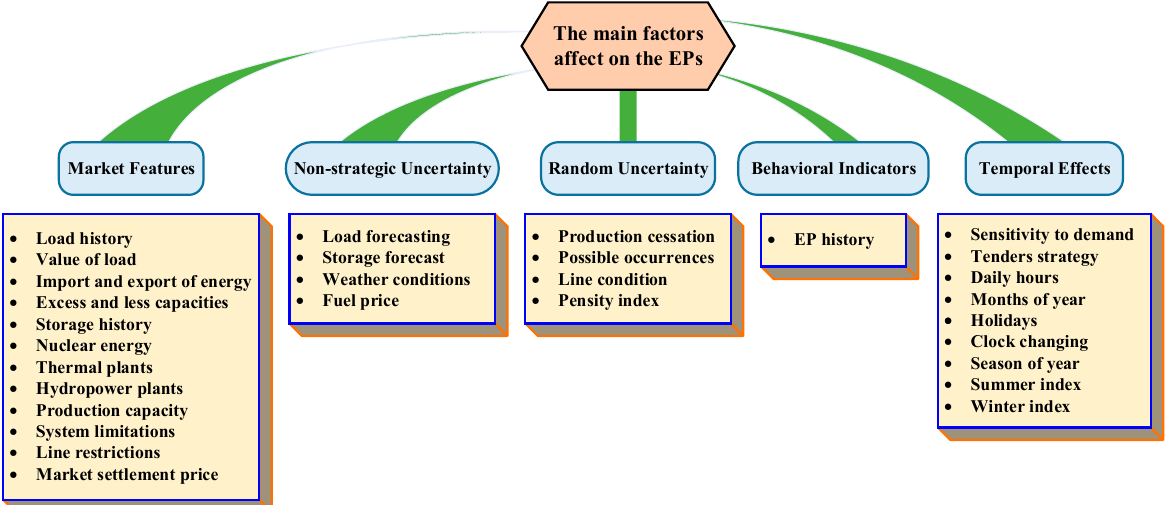
Figure 1. The various factors affecting the